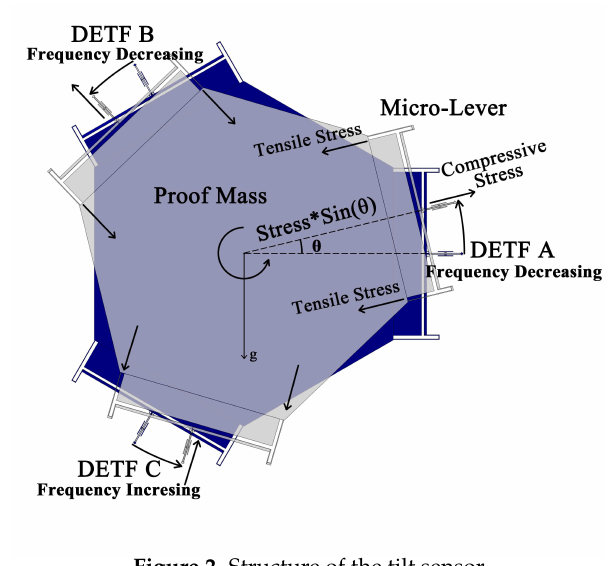
Figure 2. Structure of the tilt